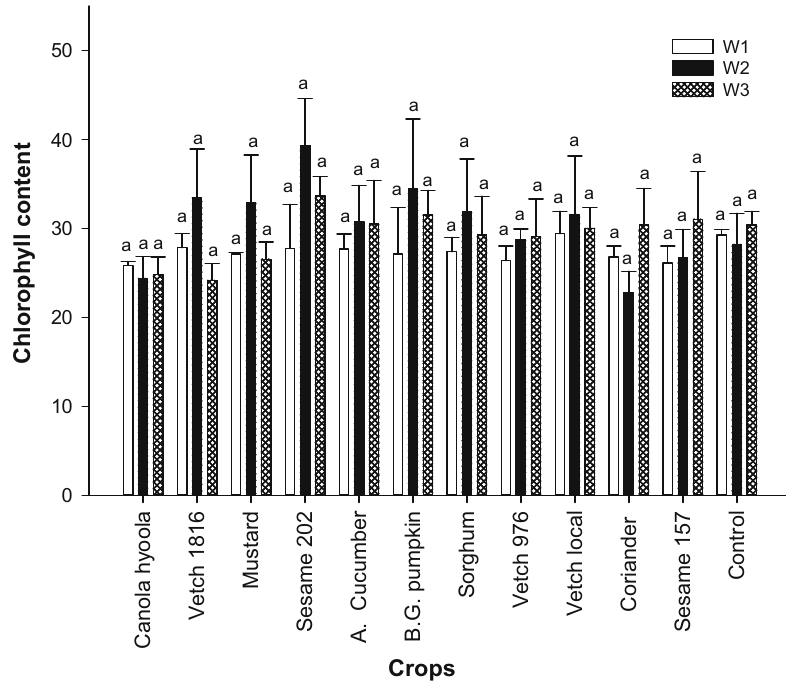
Figure 7: Lettuce chlorophyll content monitored weekly during this study. The standard deviation of the means is designated by the error bar for each mean ( SNK, P > 0.05 )